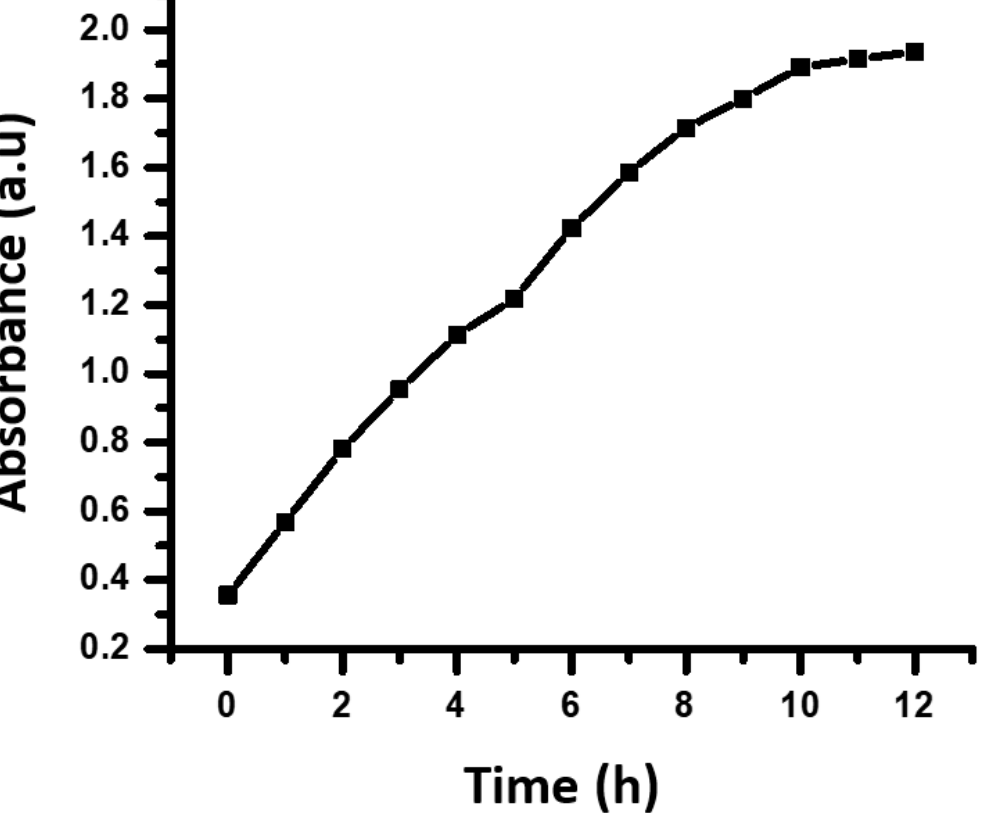
Figure 6. Absorbance of AgNPs synthesized by S . officinarum extracts at different time intervals.